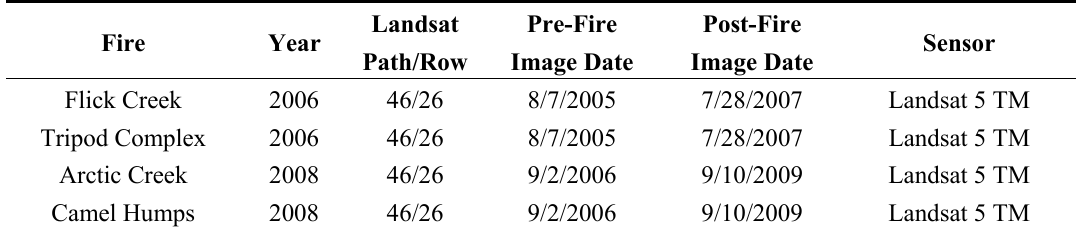
Table 5. Imagery used for each